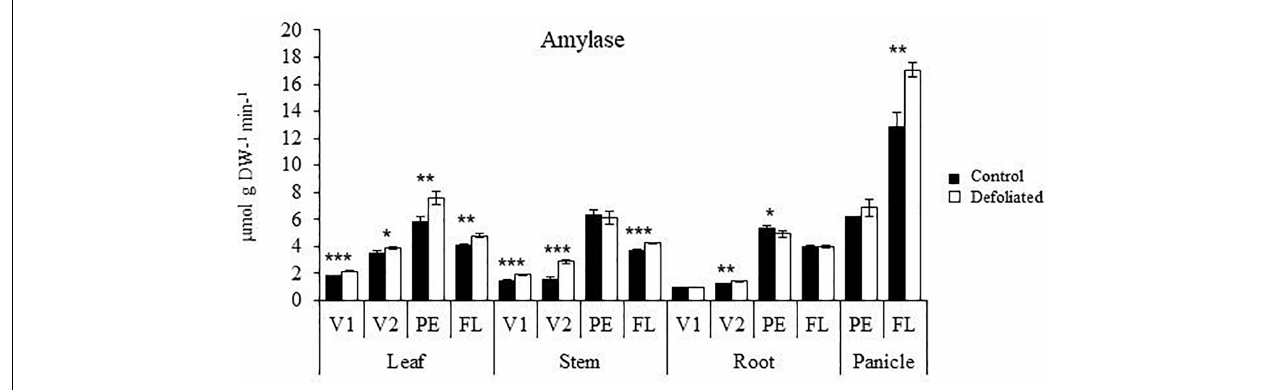
FIGURE 2 | Amylase activity in organs of defoliated versus non-defoliated Amaranthus cruentus plants. Amylase activity was quantified in leaves, stems, roots, and panicles of A. cruentus plants subjected to complete defoliation at four different development stages: Vegetative 1 (V1), vegetative 2 (V2), panicle emergence (PE), and flowering (FL). The bars represent the means ± standard error of three technical replicates obtained from three pooled plant samples produced by combining organs from nine individual plants. The results are from a representative experiment that was replicated twice. Asterisks indicate statistically significant differences between treatments at * P < 0.05, ** P < 0.01, or *** P < 0.001 for a one-way ANOVA, Tukey HSD